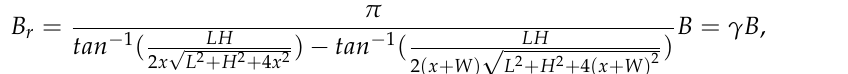
Since here the TMSB is a rectangular permanent magnet, the relationship between the remanence B r and the magnetic flux density B at certain distance x from the magnet surface in a magnetized direction can be described [21,22]: